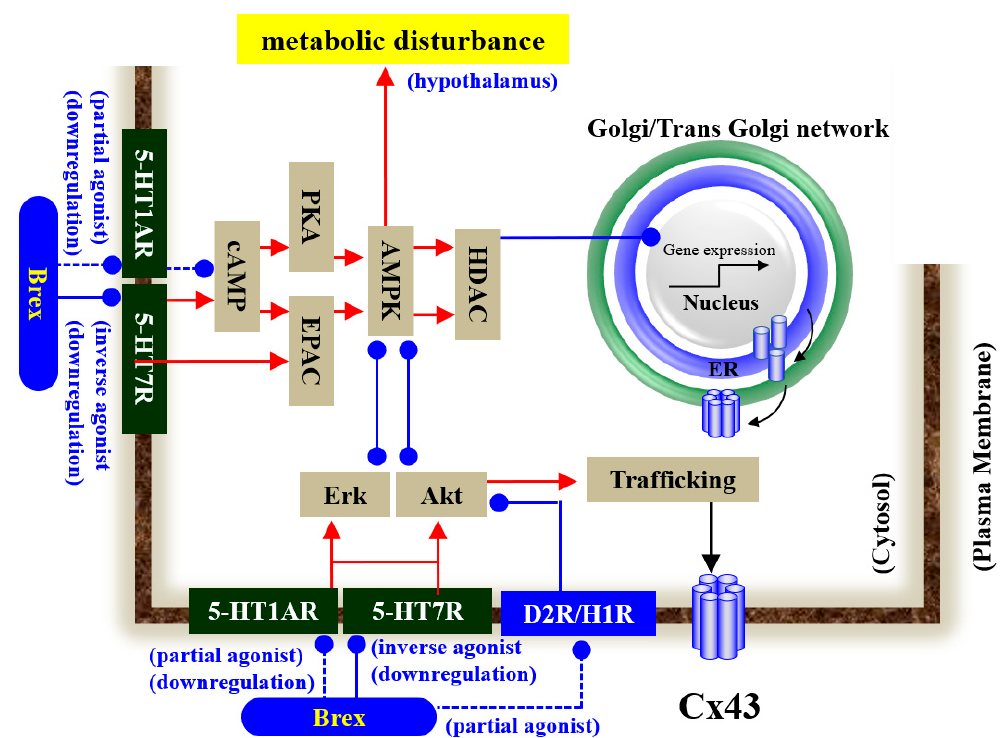
Figure 10. Proposed hypothesis of the mechanisms of Brex on intracellular signalling in astrocytes. Chronic administration of a therapeutically relevant concentration of Brex downregulates both 5-HT1AR and 5-HT7R via its 5-HT1AR partial agonistic and possible 5-HT7R inverse agonistic actions, respectively. The downregulation of 5-HT1AR and 5-HT7R by Brex attenuates AMPK, Erk, and Akt signalling in astrocytes.